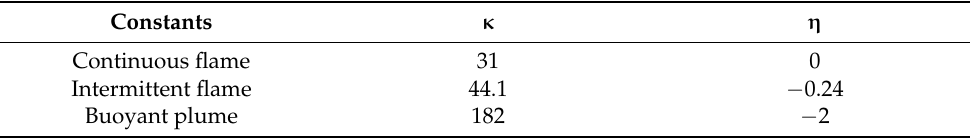
Table 4. Correlation results of the